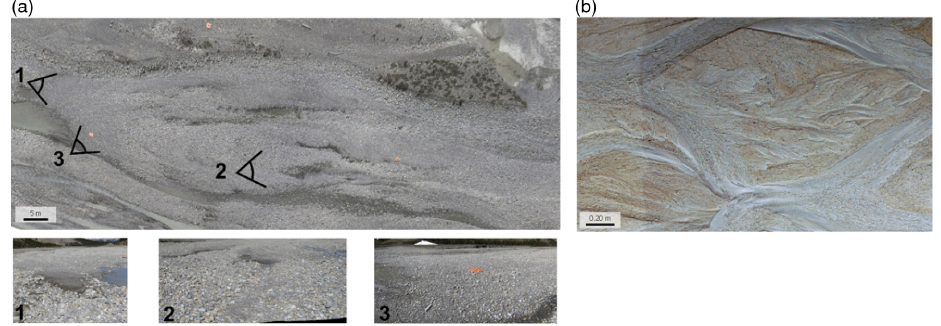
Figure 5. Grain sorting and natural pattern. (a) Vertical view of the Sunwapta River in the Canadian Rockies and (b) on the 1 / 30 model. Flow is from left to right in both bar pictures. Fine sediments are lighter gray than coarse sediments.